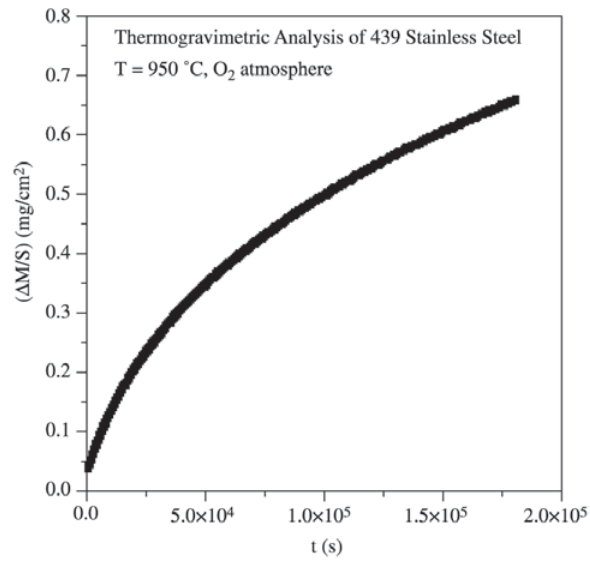
Figure 1. Evolution of the mass gain as a function of time for the 439 steel oxidized at 950 °C in oxygen.